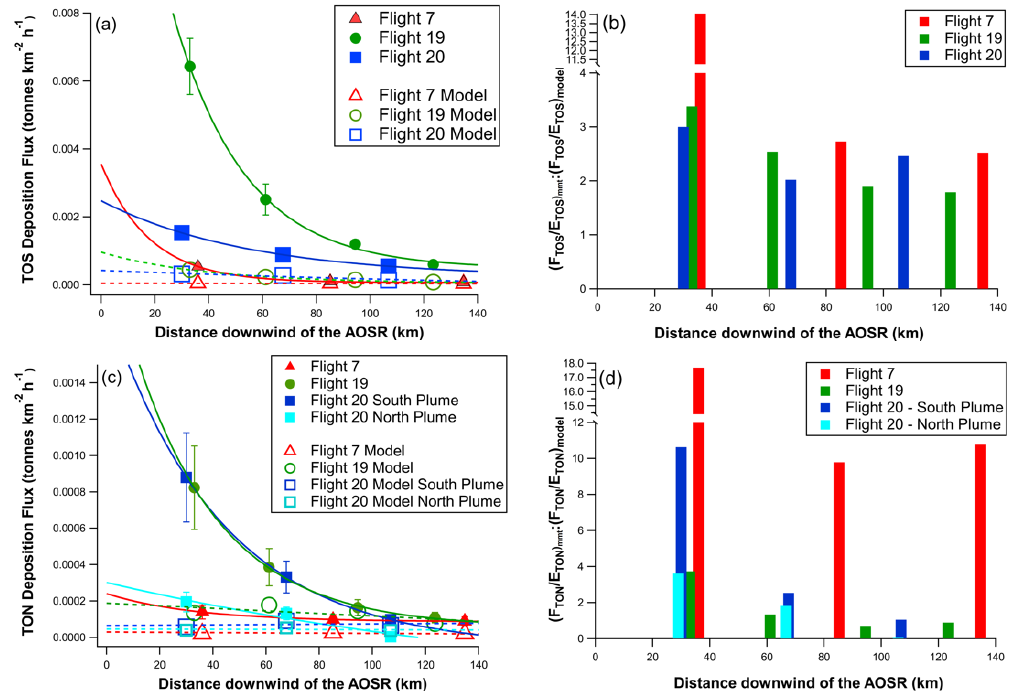
Figure 4. Dry deposition fluxes F TOS and F TON (in tkm − 2 h − 1 ) determined from measurements (solid symbols) and GEM-MACH model predictions (open symbols). (a) F TOS , (b) ratios of measurement-to-model normalized emissions F TOS /E TOS , (c) F TON , and (d) ratios of measurement-to-model normalized emissions F TON /E TON